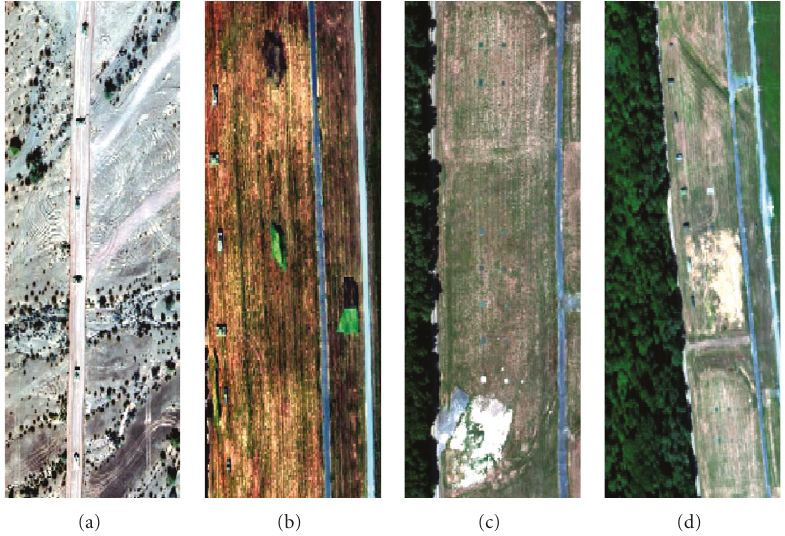
Figure 2: RGB of image scenes. (a) ARES1D, (b) ARES1F, (c) ARES2F, (d)